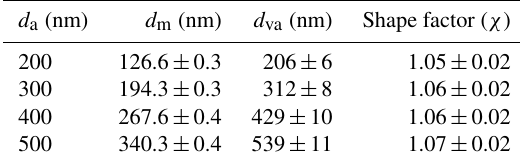
Table A1. Morphological properties of monodisperse AS aerosols selected by the AAC (in EXP P1 and P2): aerodynamic diameter ( d a ), mobility diameter ( d m ), vacuum aerodynamic diameter ( d va ), and shape factor ( χ ). The uncertainty represents the standard devi- ation of several measurements under the same selection